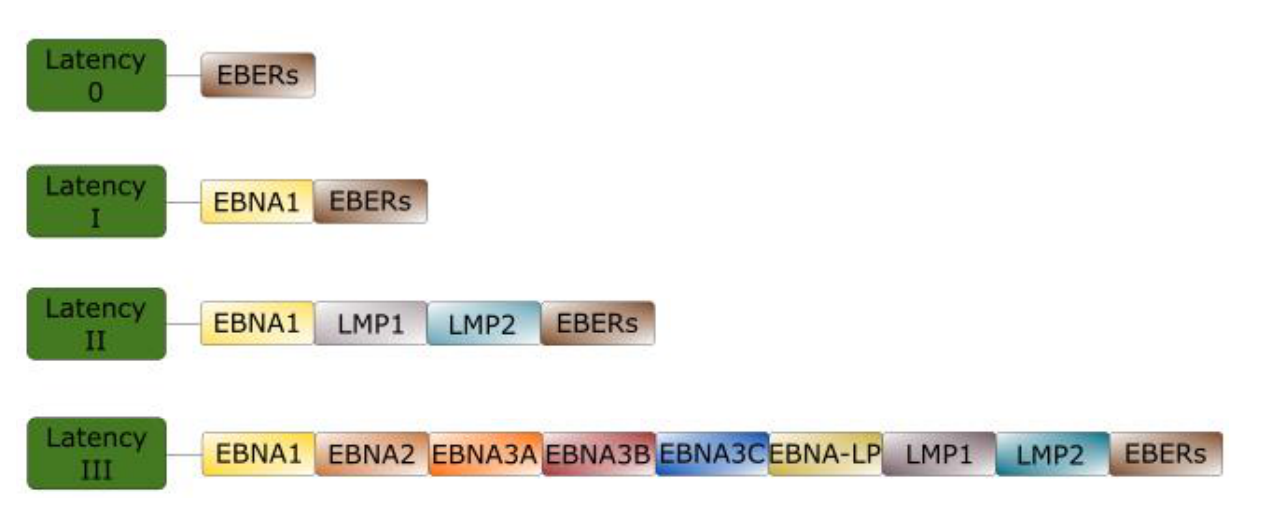
Figure 1. Patterns of gene expression in Epstein-Barr virus (EBV) latency. Following initial infection, EBV establishes 4 common patterns of gene expression termed type 0 latency, type I latency, type II latency, and type III latency. No proteins are expressed in type 0 latency. In type I latency, Epstein– Barr nuclear antigen (EBNA) 1 is the only protein expressed. In type II latency, EBNA1, latent mem- brane protein (LMP) 1, and LMP2 are expressed. Type III latency features the expression of all EBV- associated latency proteins including EBNA1, EBNA2, EBNA3, EBNA-LP, LMP1, and LMP2. Nota- bly, Epstein–Barr virus-encoded small RNAs (EBERs) are expressed in all forms of latency.